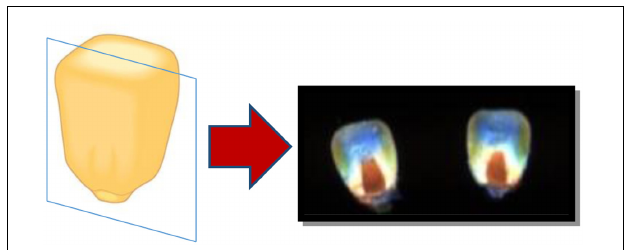
FIGURE 1 | Cross-sections were achieved by slicing each kernel vertically on a frontal plane. All cross-sections were imaged cut side up.